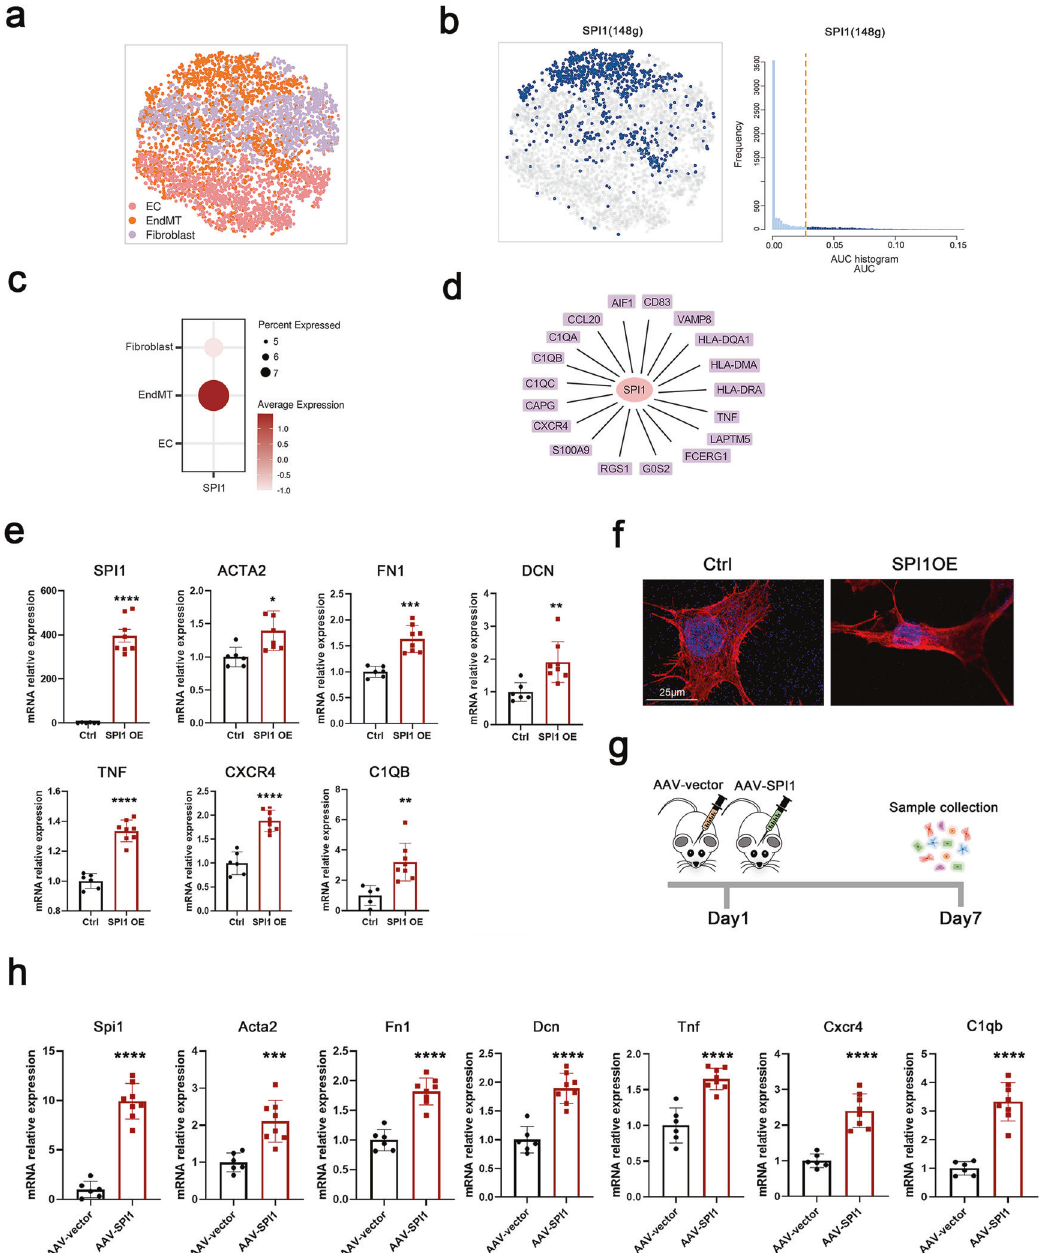
Fig. 5 SPI1 plays a key role in EndMT. a SCENIC-based t-distributed stochastic neighbor embedding (tSNE) plot for the distributions of ECs, EndMT cells and fi broblasts. b SCENIC analysis predicted the transcription factor SPI1 as a speci fi c hub (distinguished from ECs and fi broblasts) governing the EndMT cell state (left panel). SPI1 regulon activities were quanti fi ed using AUCell (right panel). c Dot plot for SPI1 expression in ECs, EndMT cells and fi broblasts. d Representative target genes of SPI1 overlapping with dynamic immune genes. e Expression levels of SPI1, EndMT markers (ACTA2, FN1 and DCN) and immune markers (TNF, CXCR4 and C1QB) regulated by SPI1 analyzed via real-time quantitative PCR (RT ‒ qPCR) assay in HUVECs after SPI1 and control plasmid transfection. f Morphological changes and cytoskeletal reorganization of HUVECs are shown by rhodamine-phalloidin staining (red) in the SPI1 overexpression and control groups. DAPI-stained nuclei are shown in blue. Scale bars, 25 µm. g SPI1 overexpression in the ECs of mice was induced by the injection of AAV-SPI1 with the TIE promoter stereotactically into the basal ganglia. Primary cerebrovascular ECs were collected 7 days after AAV-SPI1 and AAV-vector injection. h Expression levels of SPI1, EndMT markers (Acta2, Fn1 and Dcn) and immune markers (Tnf, Cxcr4 and C1qb) regulated by SPI1 analyzed via RT ‒ qPCR assay in primary ECs of cerebrovascular after AAV-SPI1 and AAV-vector injection. Primary ECs were isolated following the standard procedure of the MicroBeads kit and then used for RNA extraction and RT ‒ qPCR assay without culturing. Data are represented as the mean ± SD (AAV-vector group, n = 6; AAV-SPI1 group, n = 8). Statistics were performed using Student ’ s t test, and signi fi cance was determined as * P < 0.05, ** P < 0.01, *** P < 0.001, **** P <